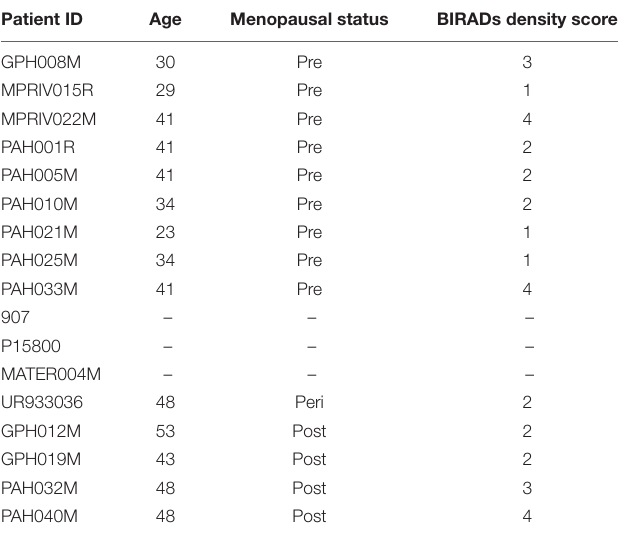
TABLE 1 | Patient demographics from which tissue was examined for this